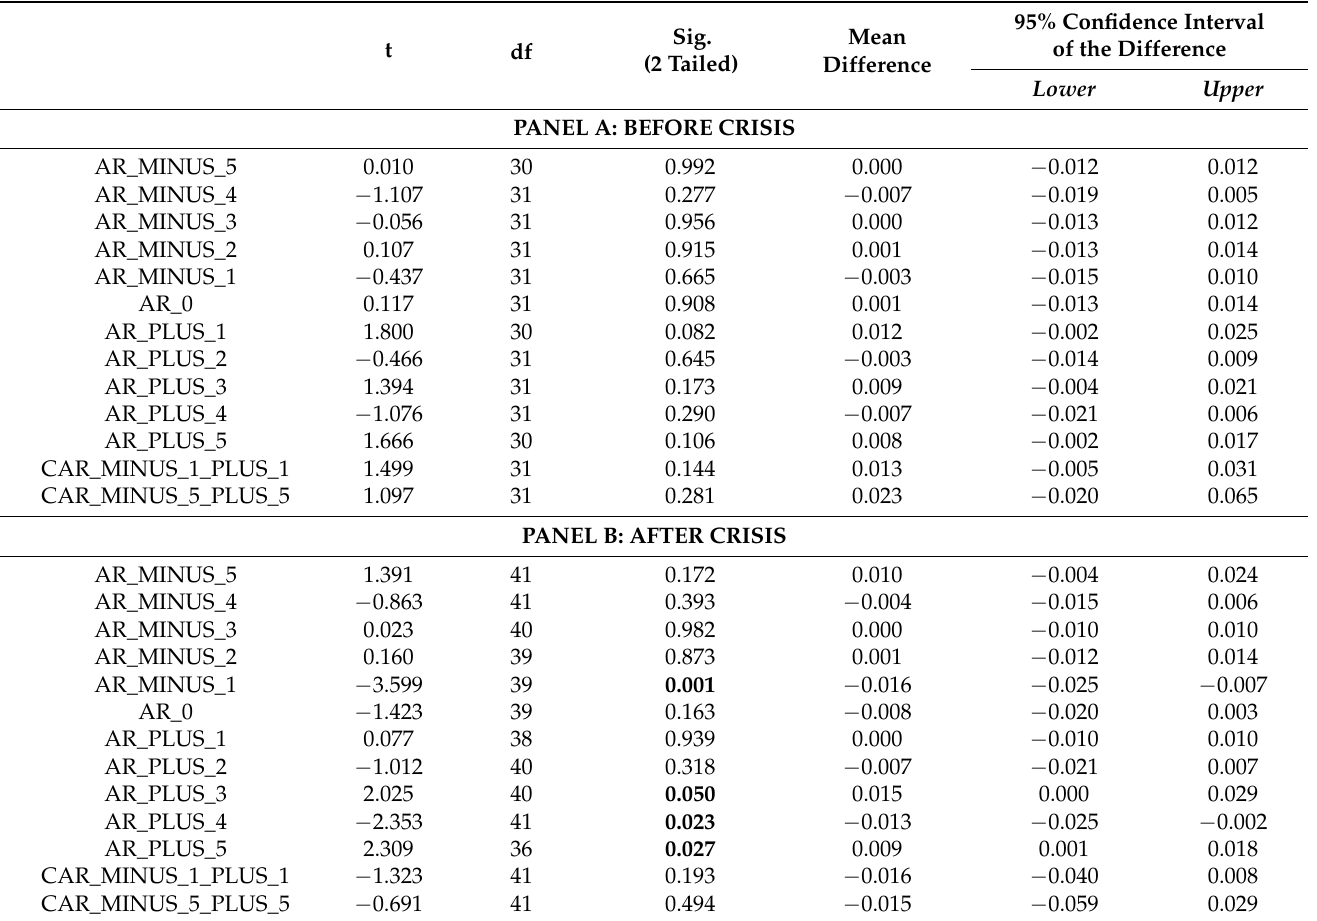
Table 9. t -test for mean difference of daily, average, and cumulative abnormal returns before and after the crisis. 95% Confidence Interval Sig. Mean of the Difference t df (2 Tailed) Difference Lower Upper PANEL A: BEFORE CRISIS